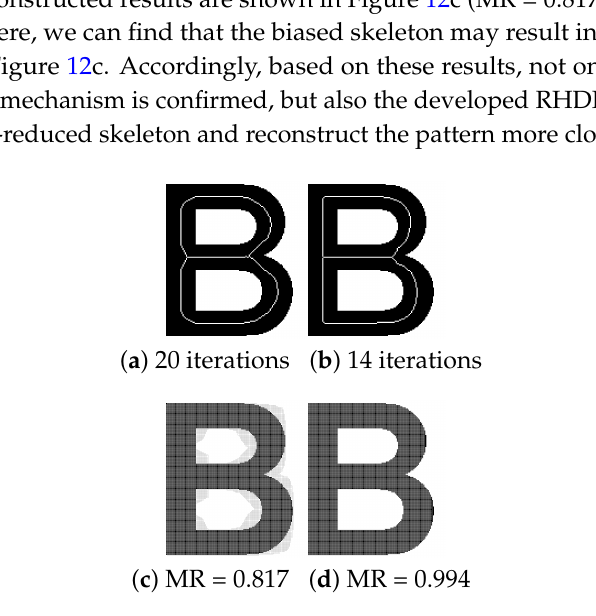
Figure 12. The thinning result obtained ( a ) without and ( b ) with the assistance of RHDP. ( c , d ) show the corresponding reconstruction result, where the original pattern pixels and the reconstructed pixels are marked by “black region squares” and “gray frame squares”